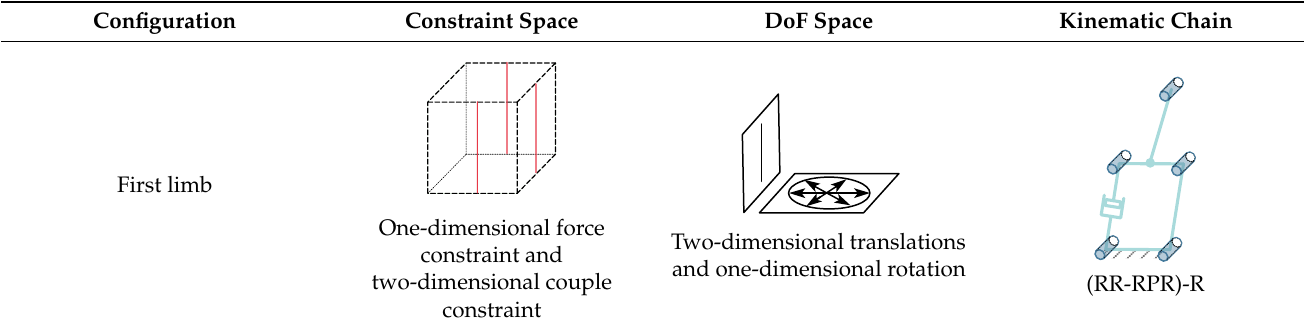
Table 1. The result of the type synthesis.